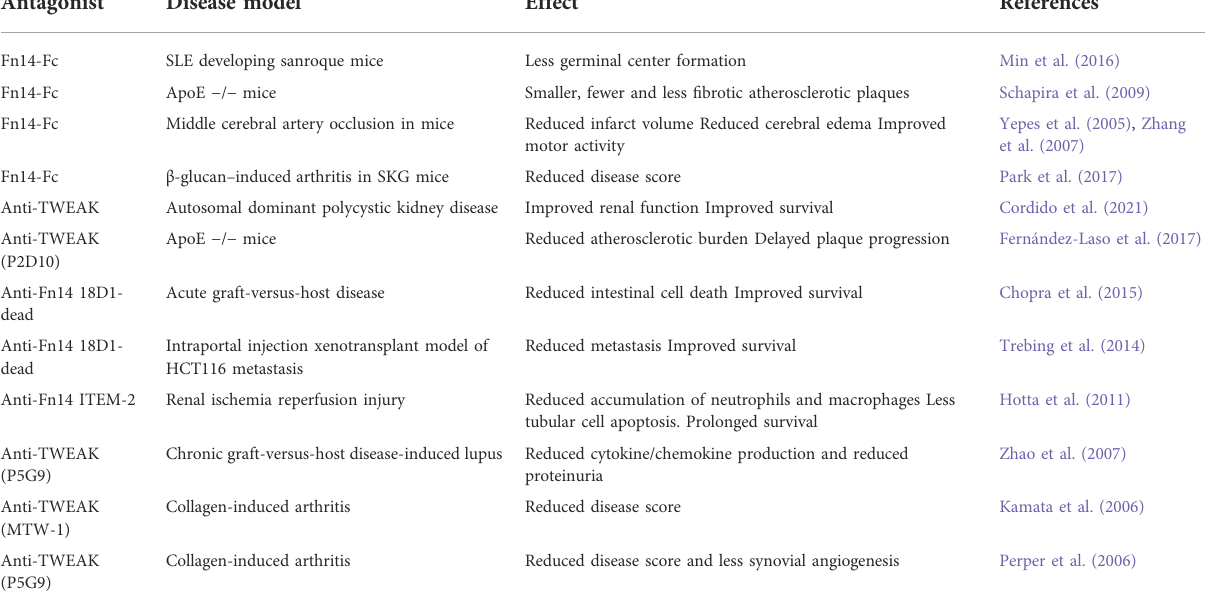
TABLE 2 Examples of the use of TWEAK- and Fn14 antagonists in preclinical disease